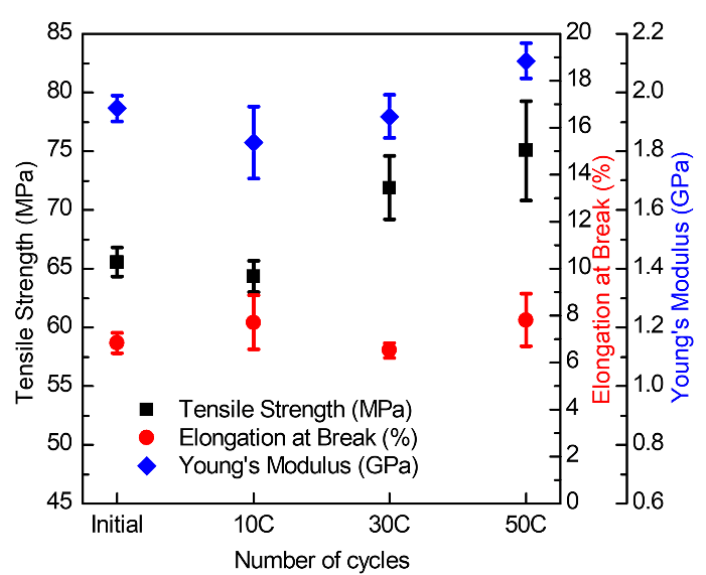
Figure 3. Mechanical properties of SMCR before and after vacuum thermal